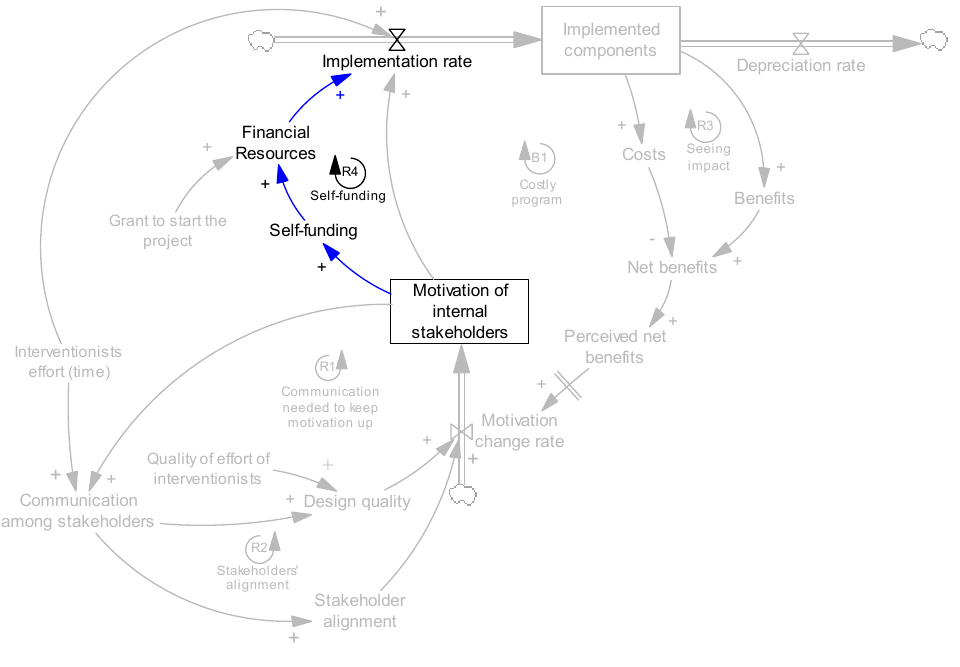
Figure 6. Self-funding mechanism.